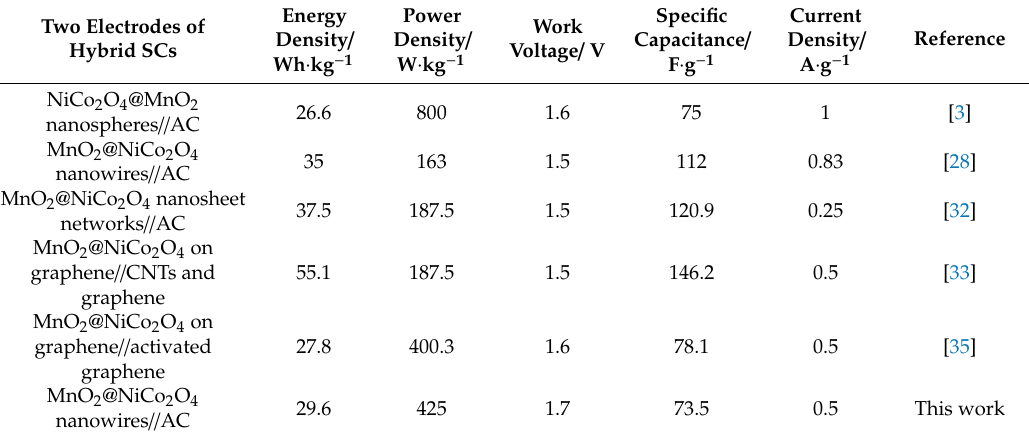
Table 1. Comparison of electrochemical properties of hybrid